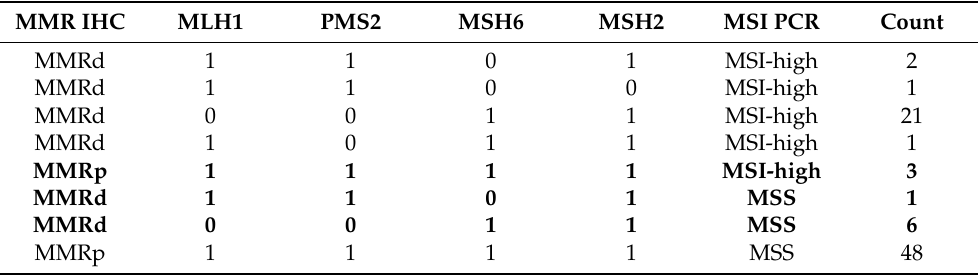
Table 4. The protein profile of POLE wildtype EC patients according to MMR IHC status and MSI PCR testing ( n =